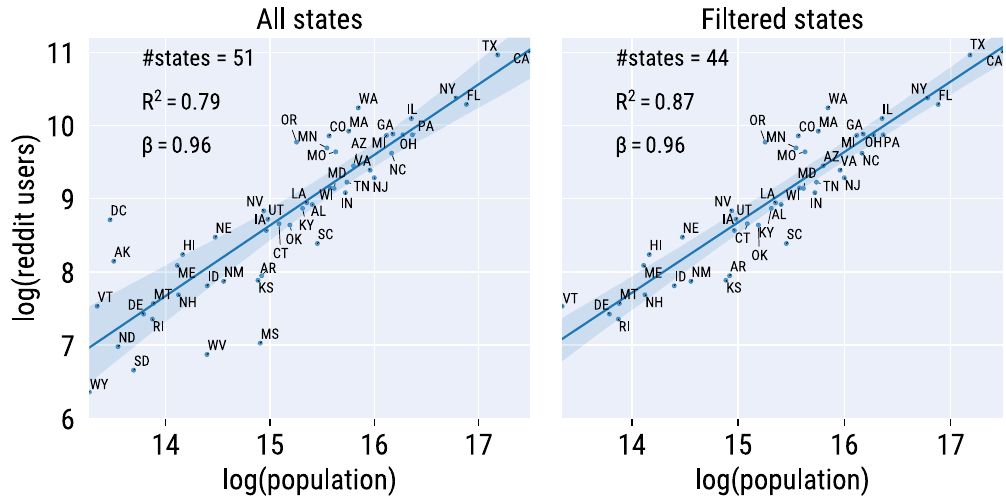
Figure 2. Relationship between population and number of Reddit users across US states. The best linear fit 2 is shown, together with its slope β and the R coefficient to measure the goodness of fit. On the left, all states are included. On the right, the states whose Reddit penetration was too low or was not proportional to the population of residents were